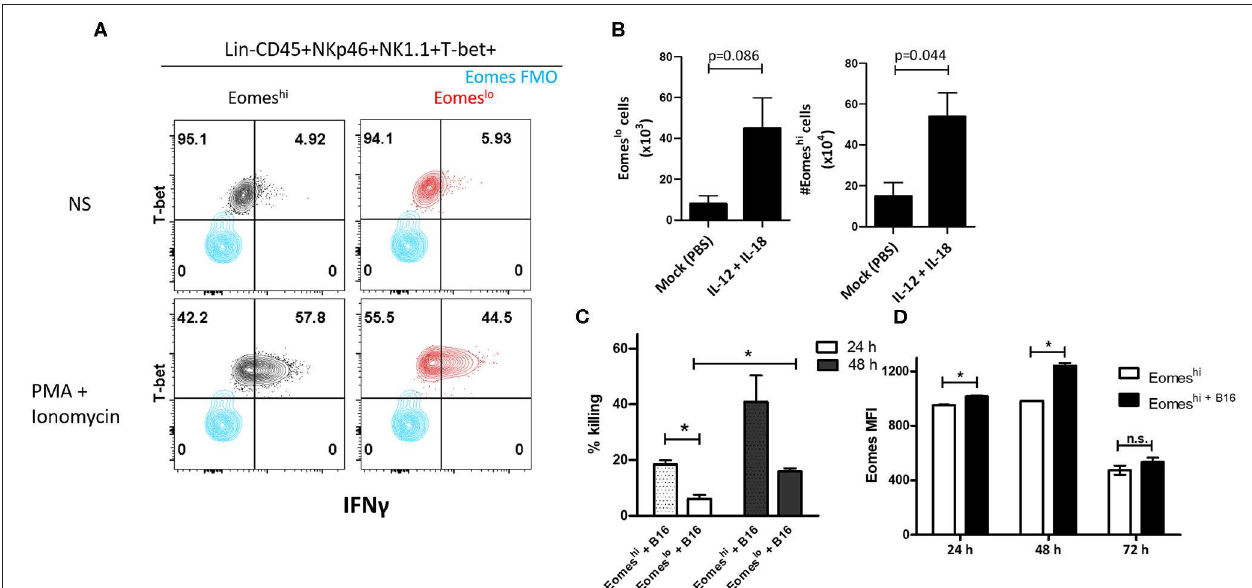
FIGURE 5 | Eomes upregulation is correlated with Group 1 ILC-mediated cytotoxicity. (A) Representation of IFN γ expression in Eomes lo and Eomes hi subsets relative to FMO controls; red—Eomes lo , black—Eomes hi ; Cells were isolated and stimulated ex vivo with PMA and Ionomycin (NS = non-stimulated) (B) Increase in Eomes lo and Eomes hi cell numbers in response to IL-12 and IL-18 stimulation in vivo. The lungs were harvested, and cells were counted at day 7. Here, n = 4 biological replicates. (C) Percentage killing of B16F10 melanoma cells by Eomes hi subset relative to Eomes lo cells at 24 and 48h, normalized to spontaneous death (B16F10 only). (D) Measurement of Eomes MFI across 24, 48, and 72h in flow-sorted murine Eomes hi Group 1 ILC in co-culture with B16F10 cells compared to Eomes hi subset alone. Cells were isolated from Eomes-GFP reporter mice; Eomes MFI is indicative of GFP MFI in the cells. Target to Effector ratio (T:E) was maintained at 4:1. MFI, Mean Fluorescence Intensity, n = 3 technical replicates, Data are representative of three independent repeats; data are presented as mean ± s.e.m.; Significance was tested using two-tailed students’ t -test; n.s., not significant * p <